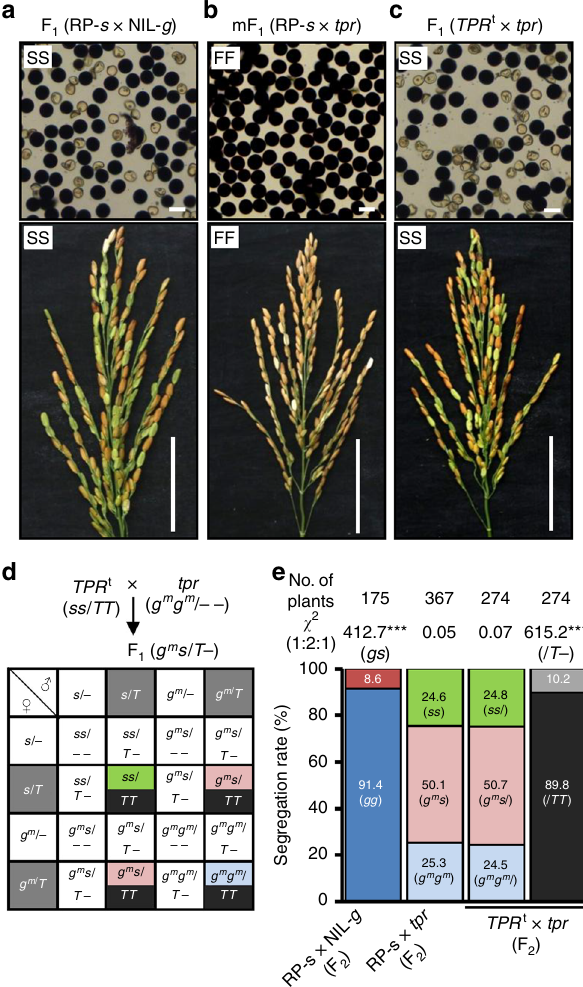
Fig. 3 Dual functions of S1TPR in S1 HS. a F 1 hybrids from crossing RP- s with NIL- g exhibited typical semi-sterile pollen and spikelets. b The pollen and spikelets of the mutant F 1 (mF 1 ) plants from crosses between RP- s and the CRISPR-knockout mutant s1tpr ( tpr ) in NIL- g ( g m g m ) were fully fertile. c The F 1 plants from a cross between the S1TPR t ( TPR t , ss / TT ) and tpr ( g m g m ) lines exhibited semi-sterile pollen and spikelets. Bars in ( a – c ) represent 50 μ m for pollen and 5 cm for panicles. d A proposed model for the segregation of the S1 alleles and transgenes in the F 2 progeny of the TPR t × tpr cross. The F 1 male and female gametes containing the T allele (gray background) are fertile, and those without T (white background) generally abort. The color codes are consistent with the genotype of the individuals in the F 2 population. Black represents homozygous TPR t ; green represents homozygous S1-s ; pink represents heterozygous mutated S1 ; light blue represents homozygous mutated S1-g m . e Segregation rates of the S1 alleles and transgenes ( T ) in the F 2 plants shown in ( a – c ). *** P < 0.001 in the Χ 2 test. Source data of ( e ) are provided as a Source Data fi